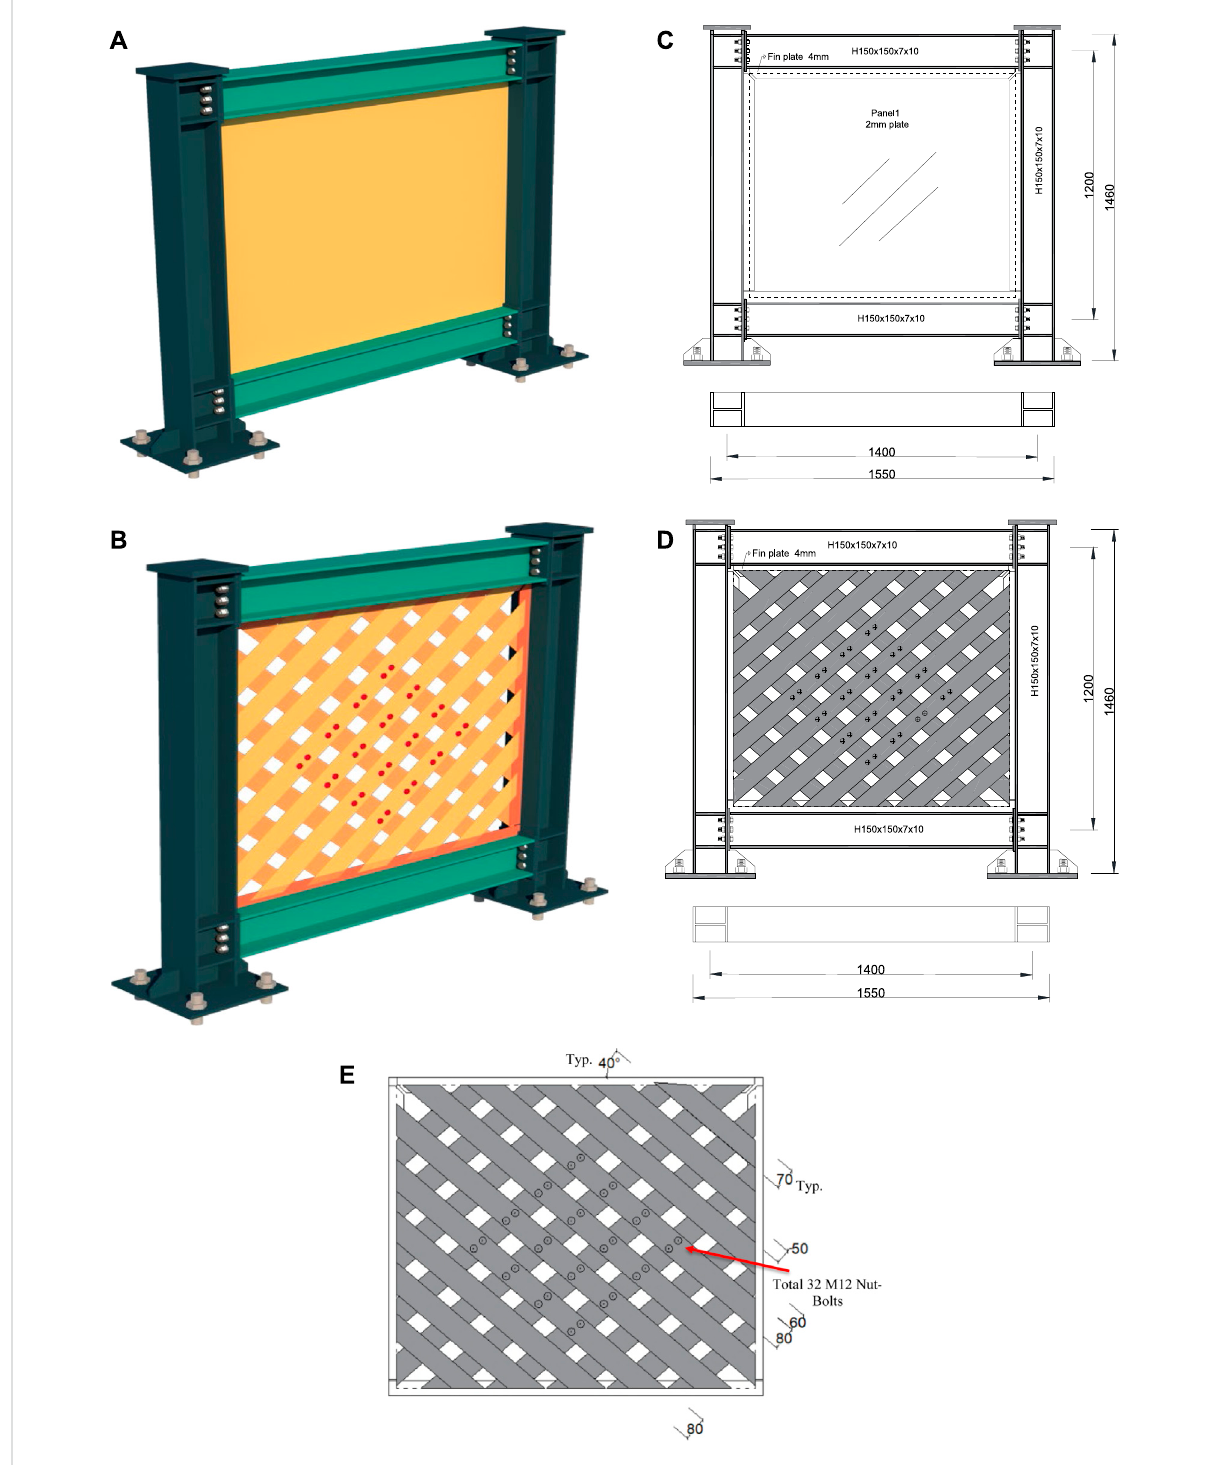
FIGURE 1 Geometric sketch of specimens (unit: mm): (A) Isometric view of USPSW; (B) Isometric of IWS-SPSW; (C) Front and Top -view of USPSW; (D) Front and Top view of IWS-SPSW; (E) In fi ll strips con fi gurations and